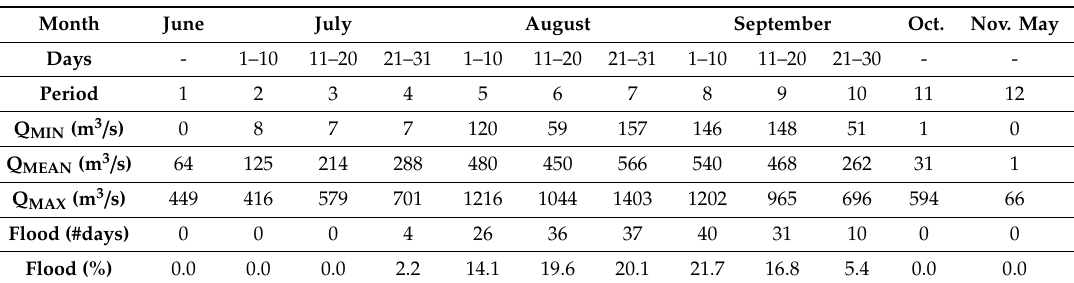
Table 5. Probability occurrence evaluation of the 12 homogeneous periods of the wet season in the last hydrological period